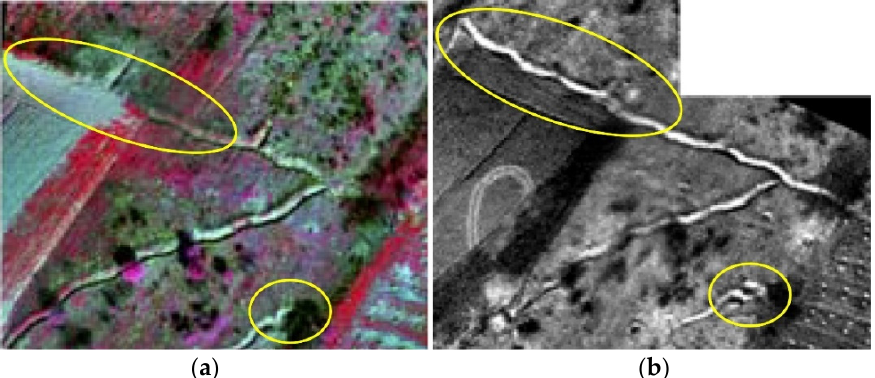
Figure 14. Examples of images of part of suspected hazardous area (from a height of 260 m, M b ≈ 1:10,800) collected using sensors ( a ) multi-spectral VNIR and ( b ) panchromatic LWIR on which trenches can be seen (yellow ellipses).